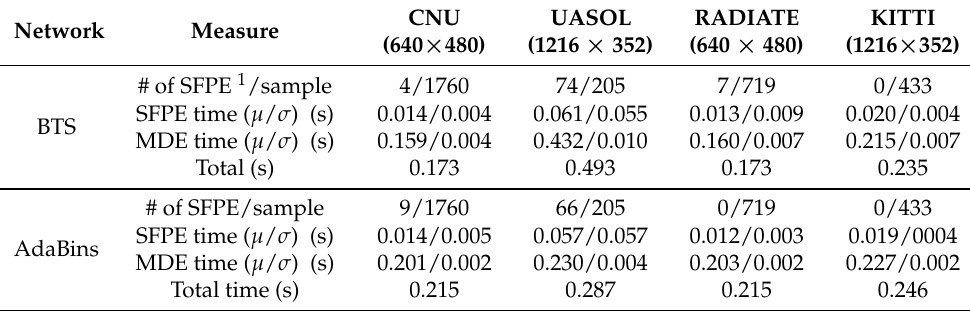
Table 4. Computational performance.